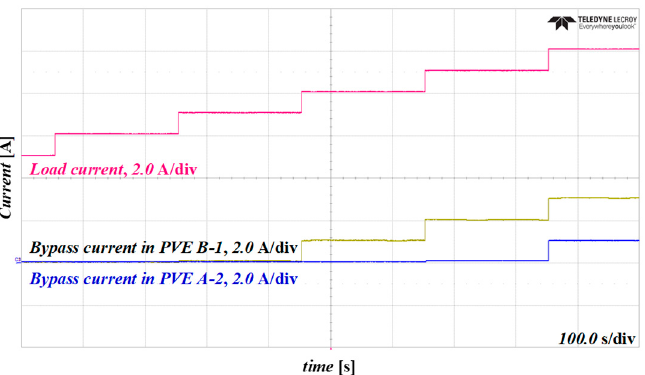
Figure 25. Experiment results: Output (load) current and bypass currents in multiple series connec- tion of three PVEs. tion of three